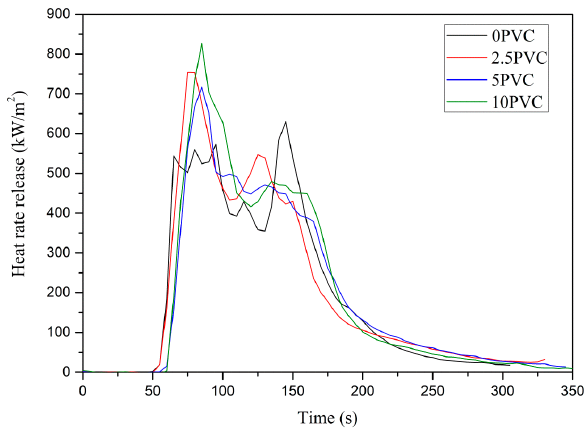
Figure 7. Representative heat release rate curves of the composites.